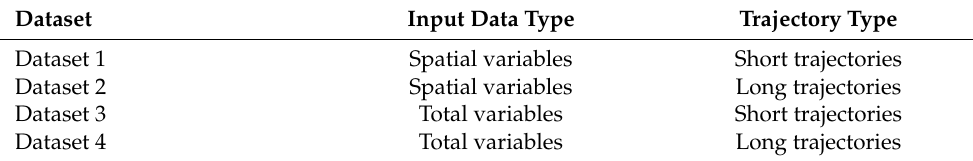
Table 2. Summary of datasets used in experiments.